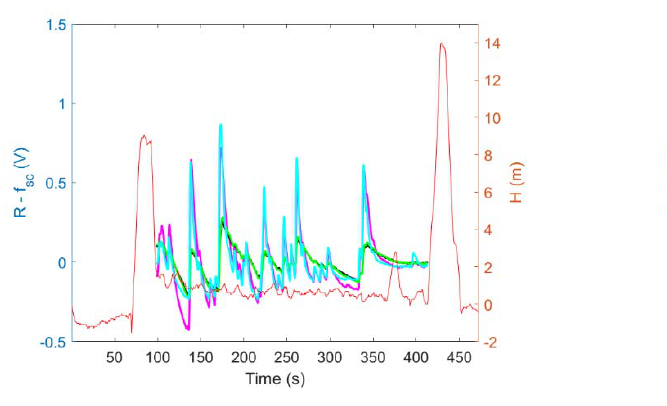
Figure 17. The variation of gas sensor signals recorded during experiment CE2 when the sensing platform was: ( a ) lowered from the drone, ( b ) docked under the drone. Gas sensor signals without systematic components are shown using the following colors: GM102B (magenta), GM302B (black), GM502B (green), and GM702B (cyan). The red line indicates the sensing platform height above the ground.